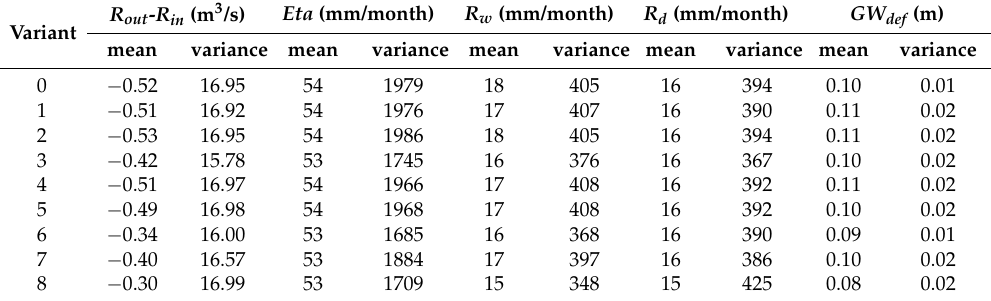
Table 2. Mean annual values and variance of the different water balance components: difference between outflow and inflow of the wetland ( R out -R in ), evapotranspiration ( Eta ), water withdrawal ( R w ), drainage ( R d ), and groundwater deficit ( GW def ) of the Spreewald wetland for all variants (n = 132). The mean annual value of all inflows to the wetland ( R in ) is 20 m 3 /s (minimal monthly value: 6.3 m 3 /s, maximal monthly value: 44.7 m 3 /s).